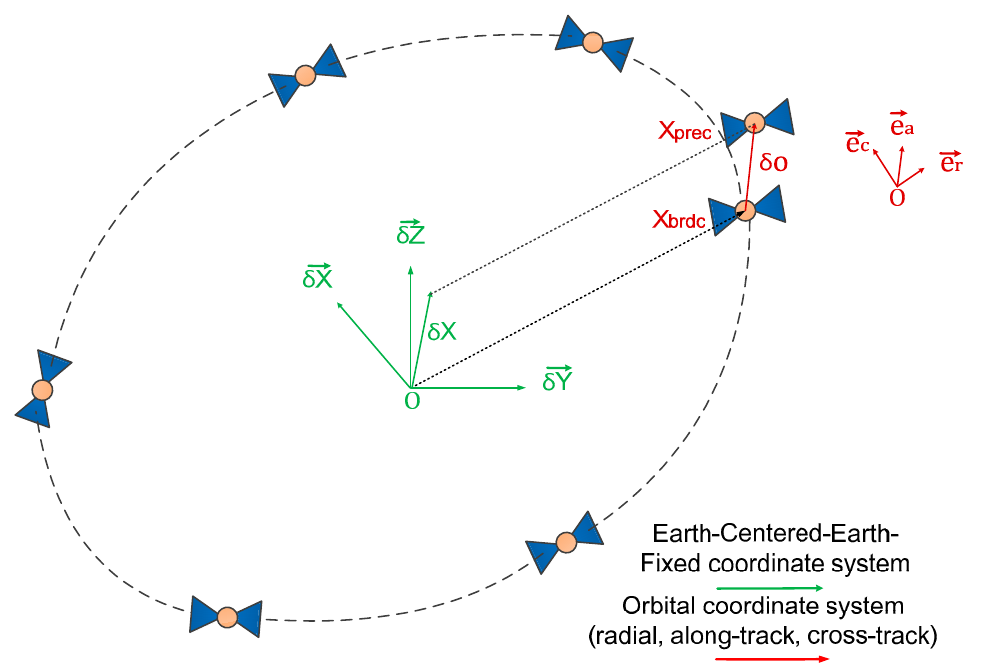
Figure 1. The geometry sketch of real-time precise orbits recovered from IGS RTS correction prod- ucts.